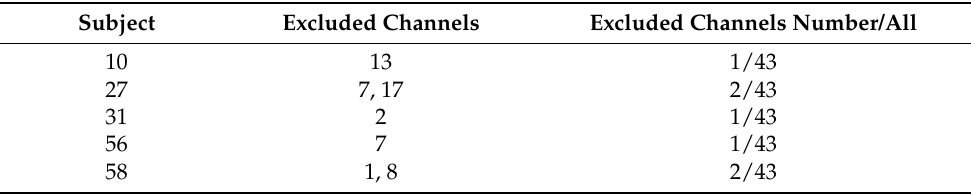
Table 1. Data channel loss due to dark noise or saturation.